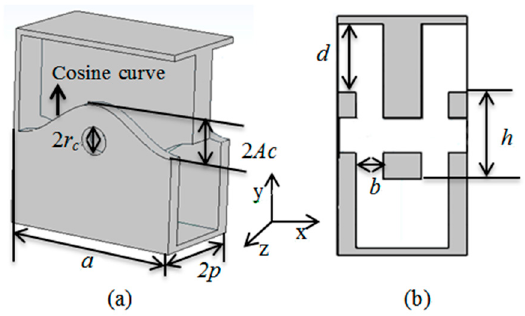
Figure 1. Schematic of single period CV-FWG: ( a ) 3D cut-away solid model and ( b ) cross-sectional view of the CV-FWG.